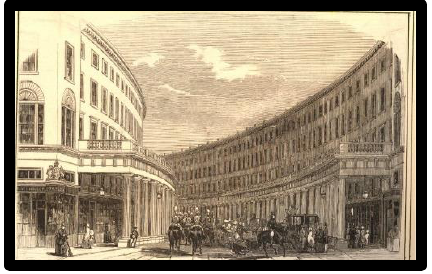
Figure 16 : Anonymous (1848), The Quadrant. (URL 12).